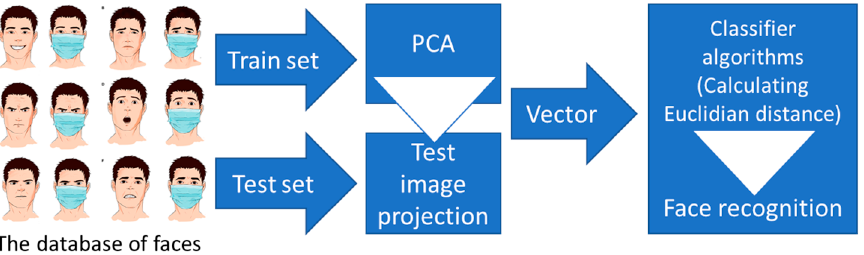
Figure 3. PCA approach for FR